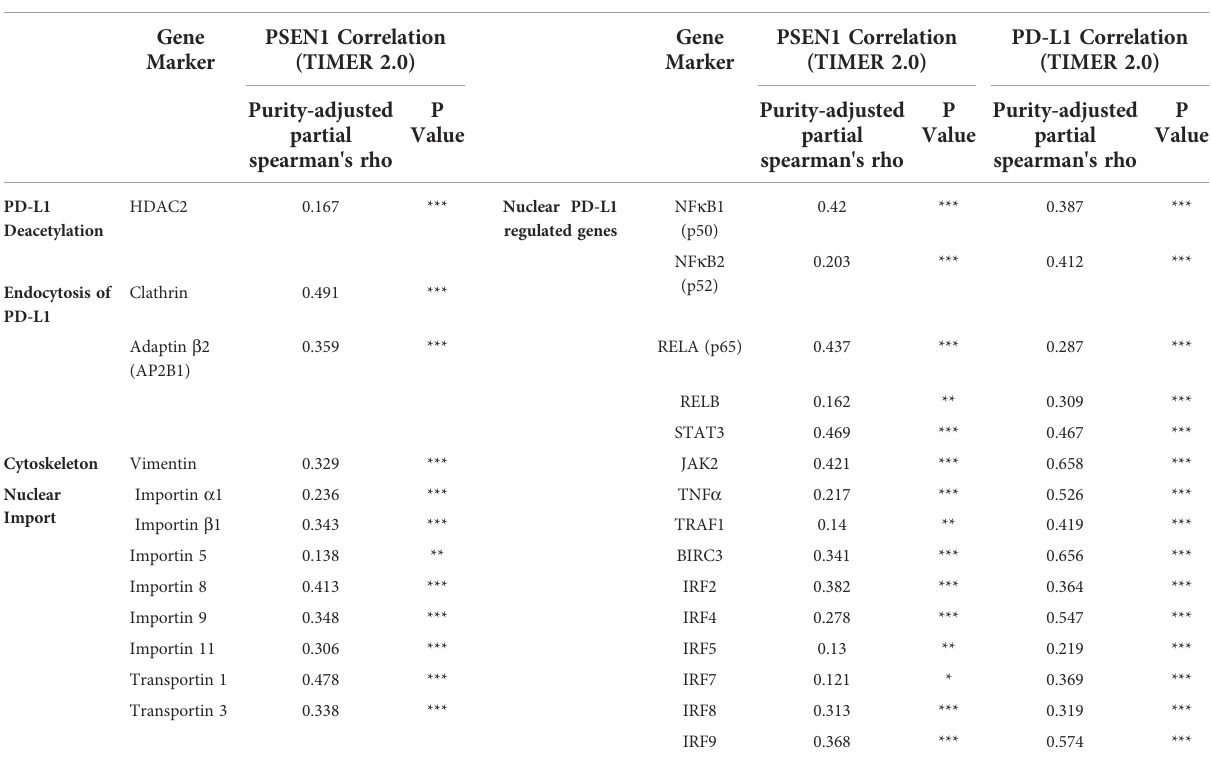
Colon Adenocarcinoma